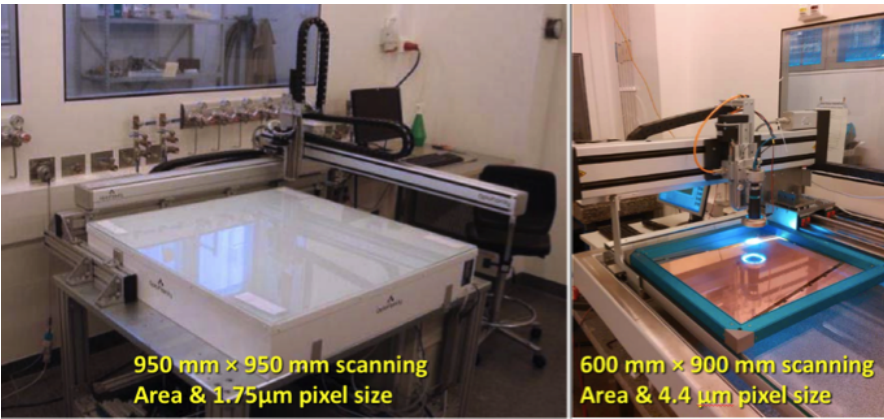
Figure 4. The Helsinki computer controlled optical scanning